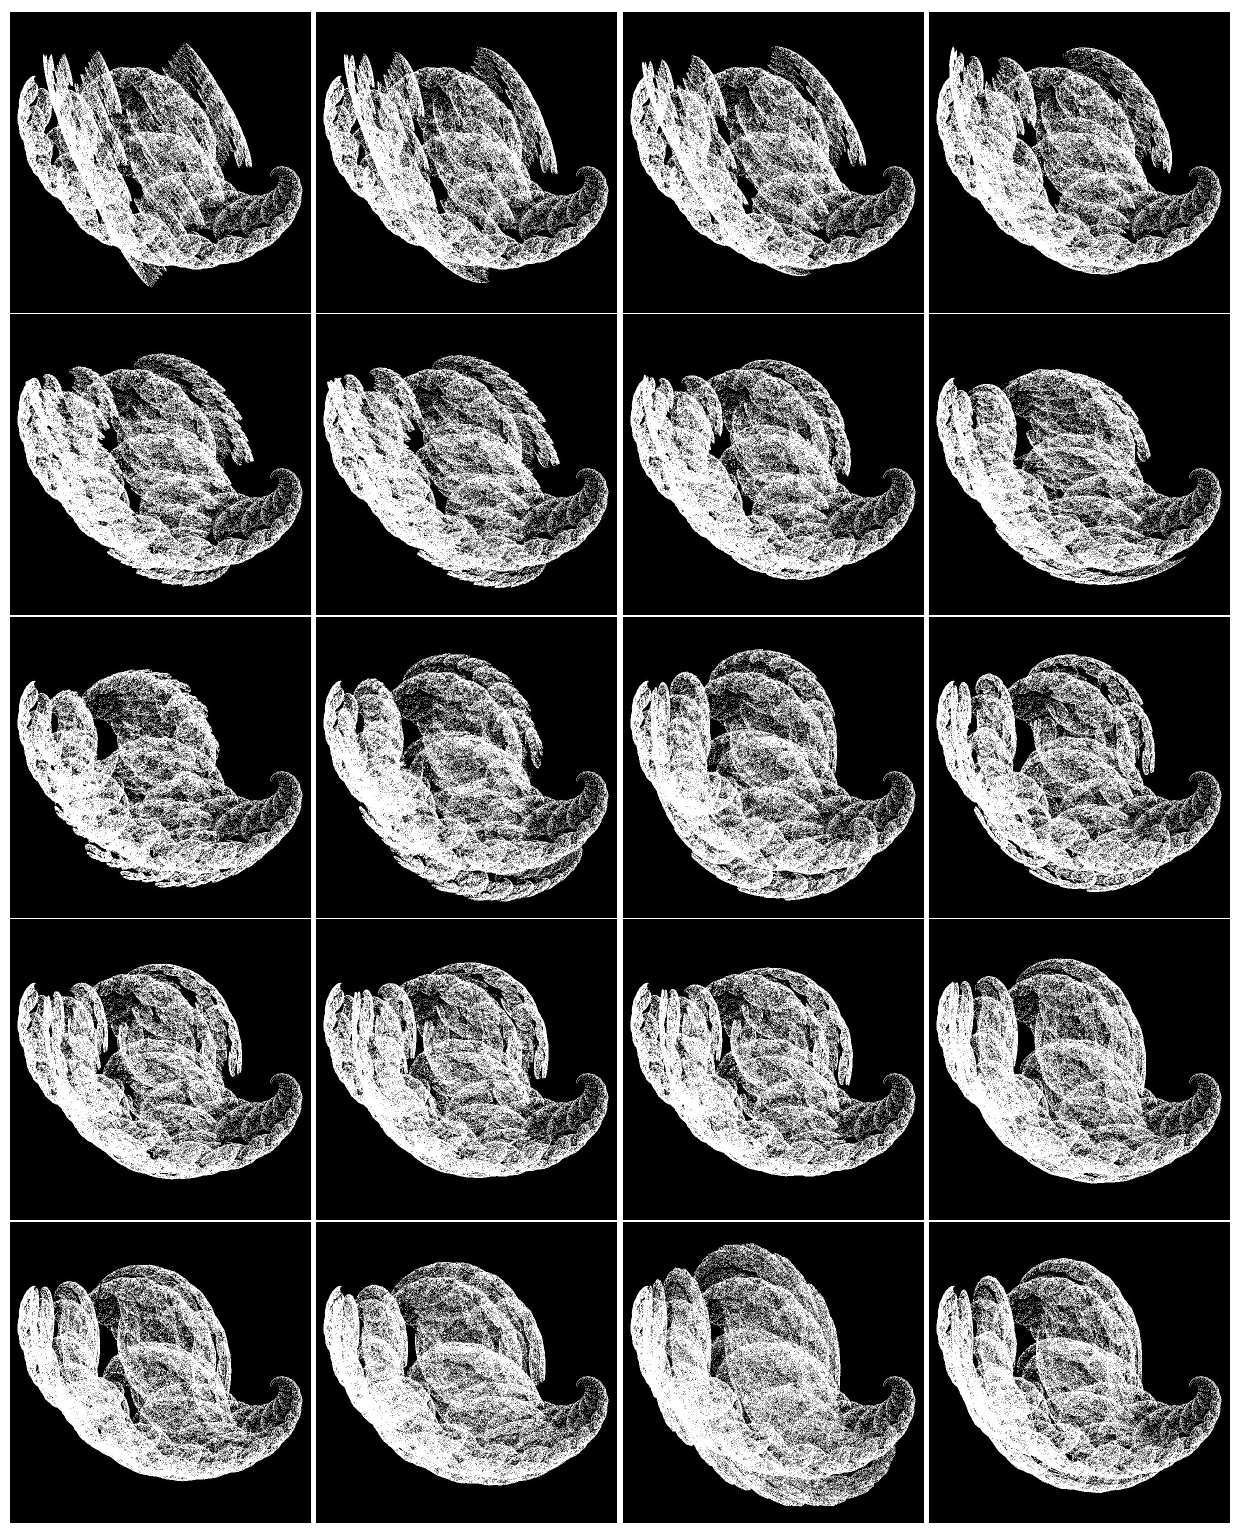
Figure 11. ( left – right , top – bottom ): Evolution of the union between the original and the recon- structed images for 400–780 iterations (step size, 20